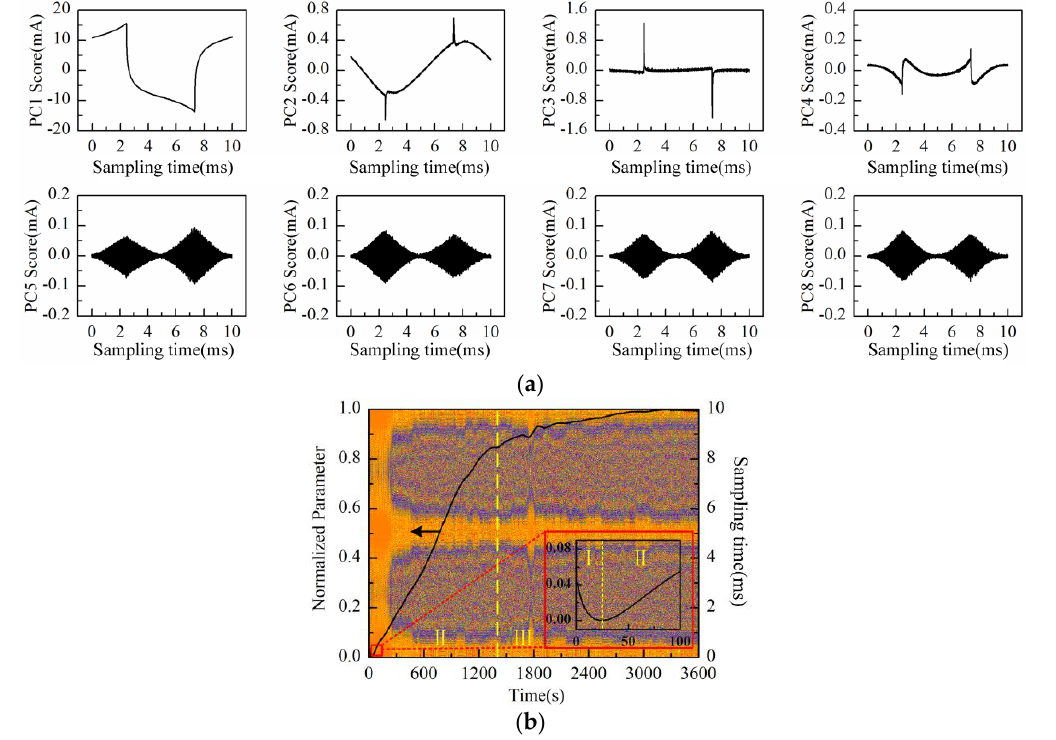
Figure 12. Measurement results of the KCl background solution conducted with Au-Cu-IDT: ( a ) PC1–PC8 scores plot; ( b ) PC1 loading curve (after SSA) and the reconstructed noise image.